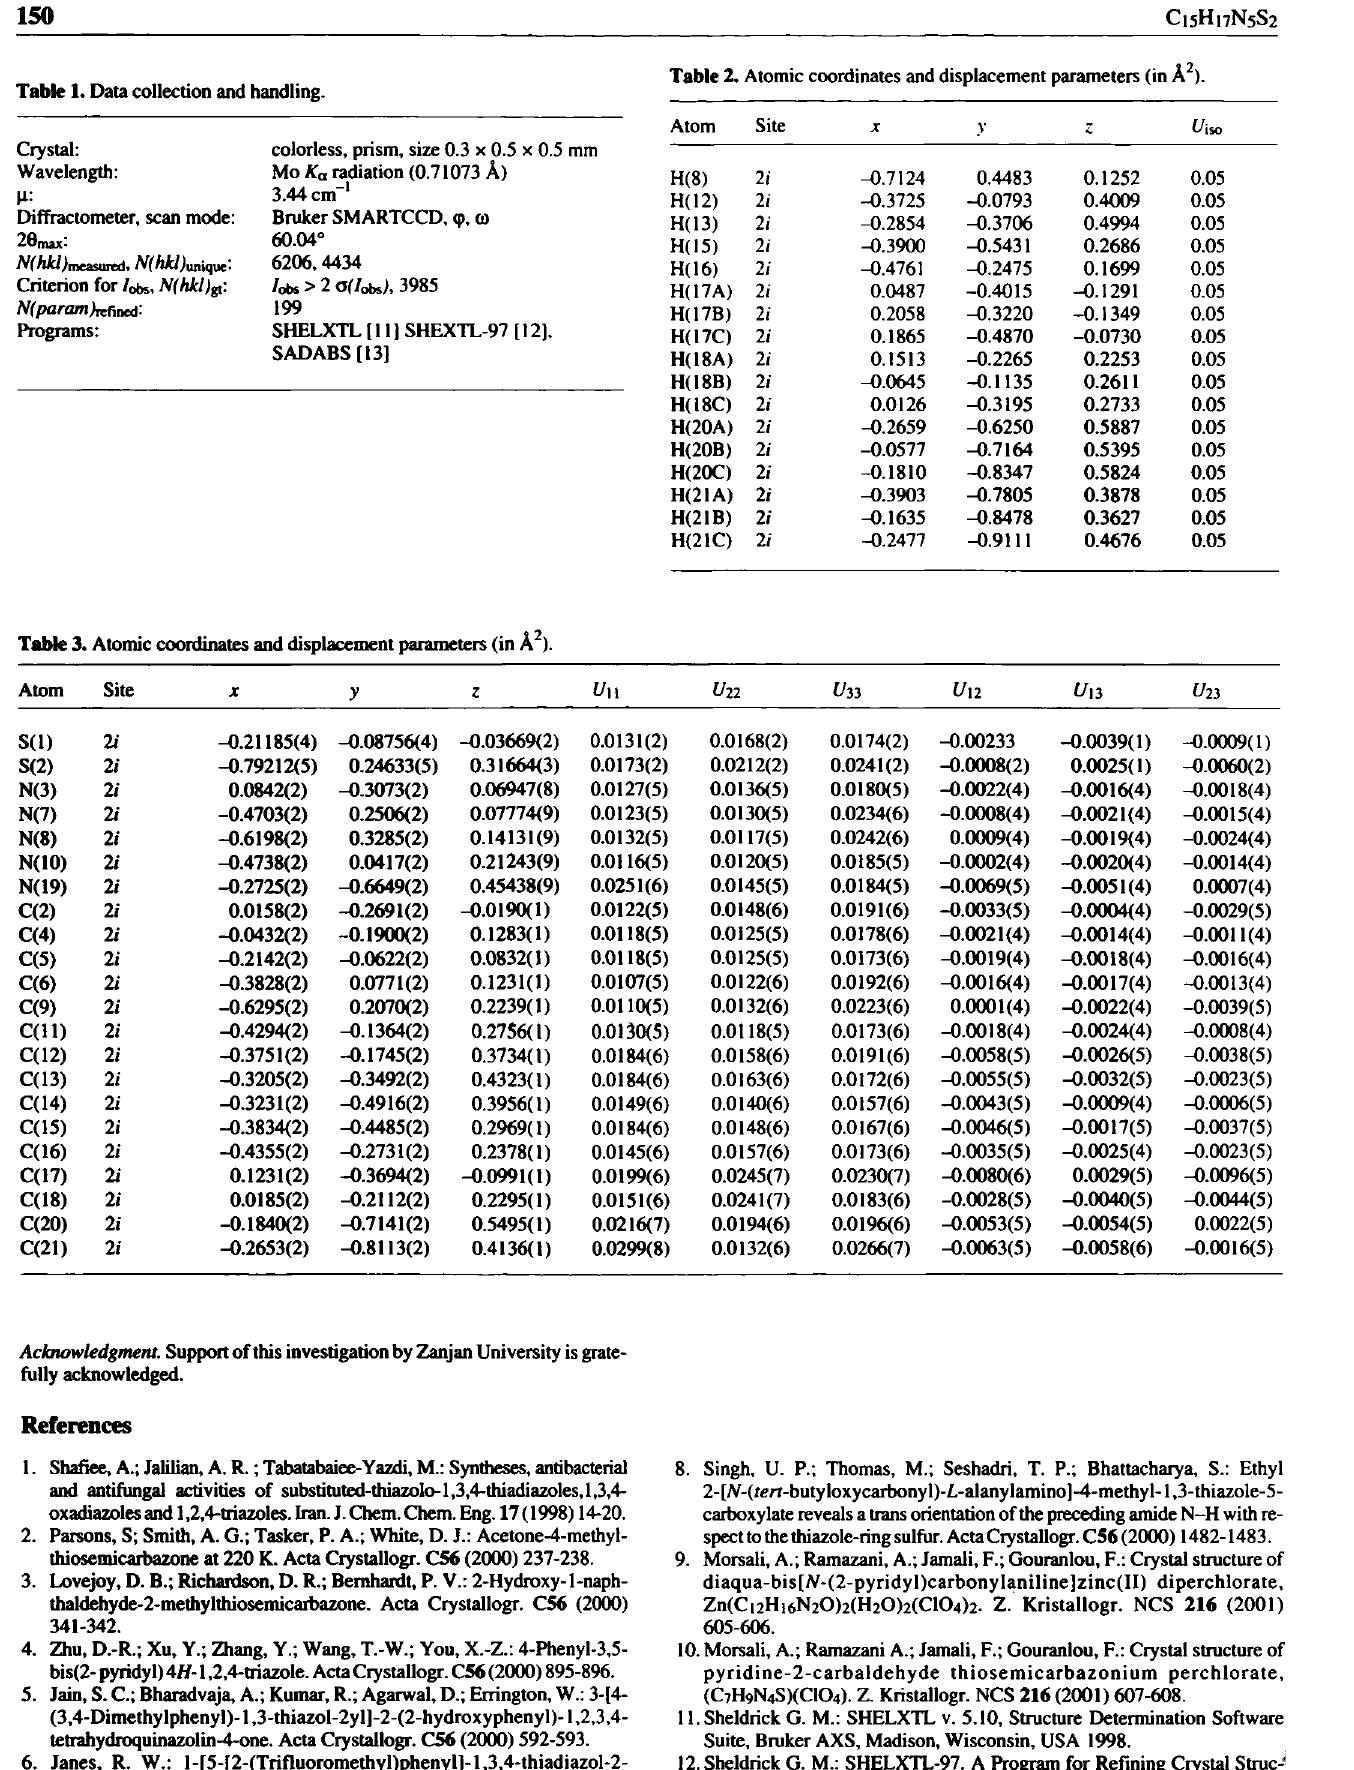
Table 2. Atomic coordinates and displacement parameters (in À 2 ).